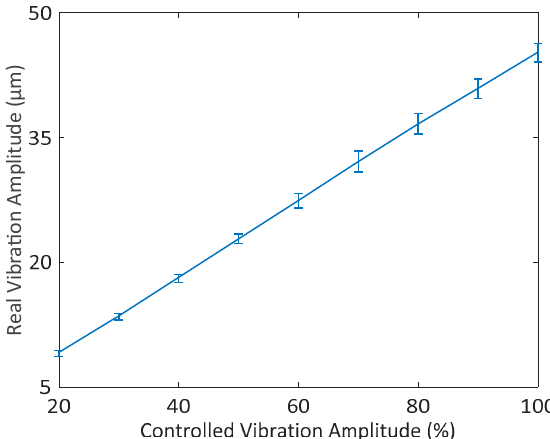
Figure 16. Real vibration amplitude under different control targets.